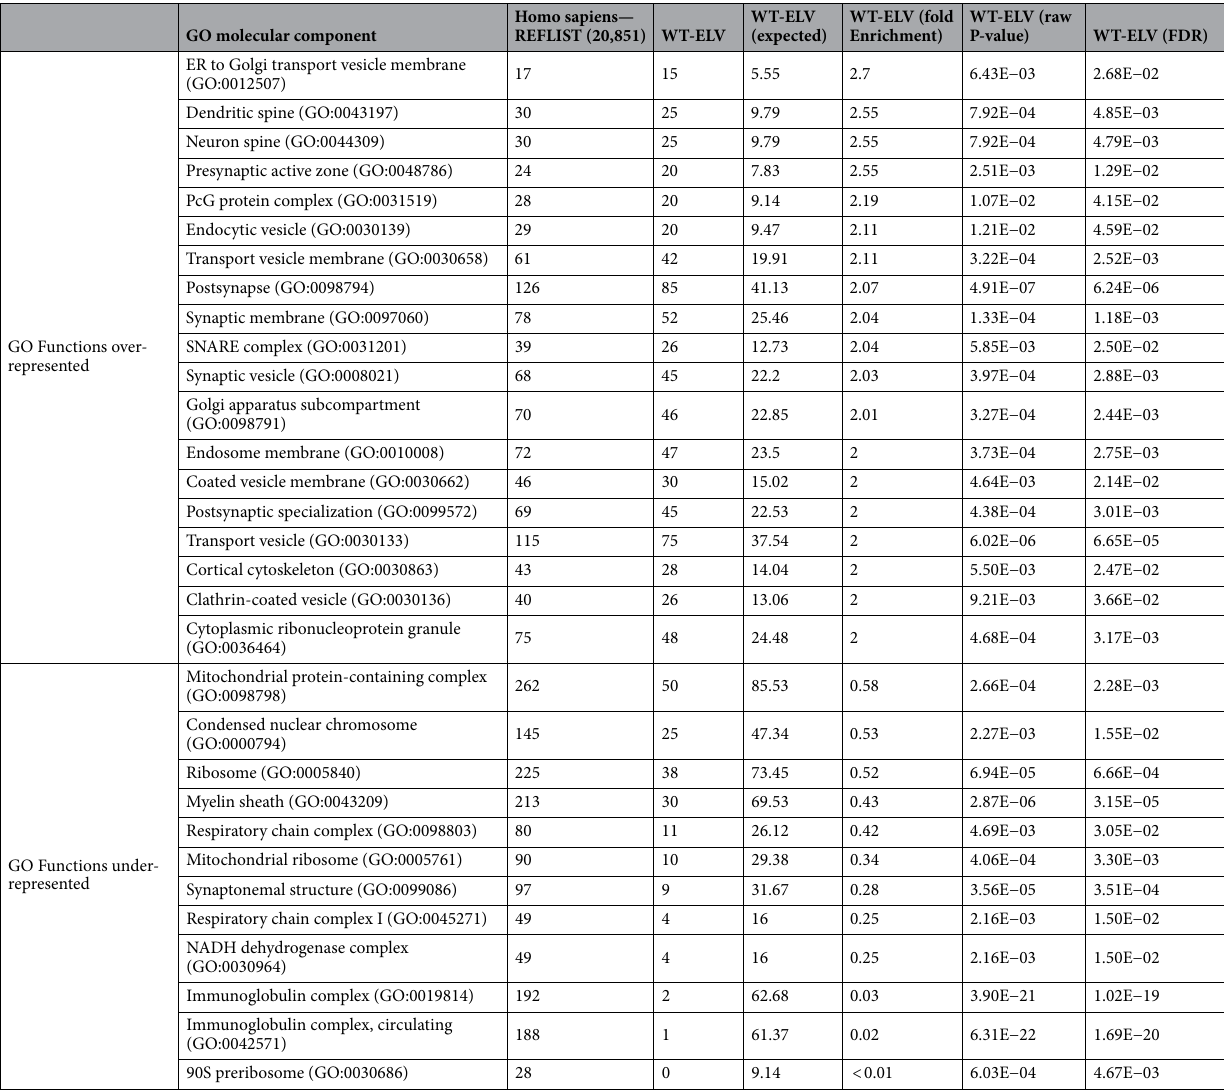
Table 2. Gene Ontology pathways significantly enriched in genes targeted by quadriceps-released WT-ELV miRNAs. Target genes predictions are from TargetScan 6.0. Significant pathways are from PANTHER version 15.0 (PANTHER Overrepresentation Test). Only functions with more than twofold enrichments (+ or -) are